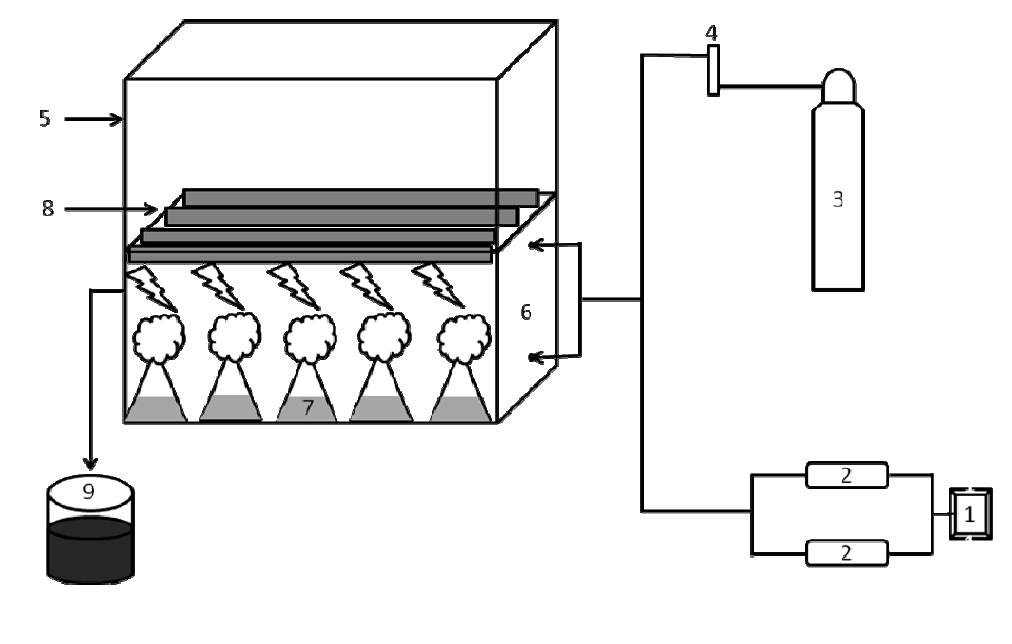
Figure 5. Diagram of the experimental CO (3) CO gas cylinder (4) Flow meter (5) Culture rack (6) CO 2 Light source (9) Saturated